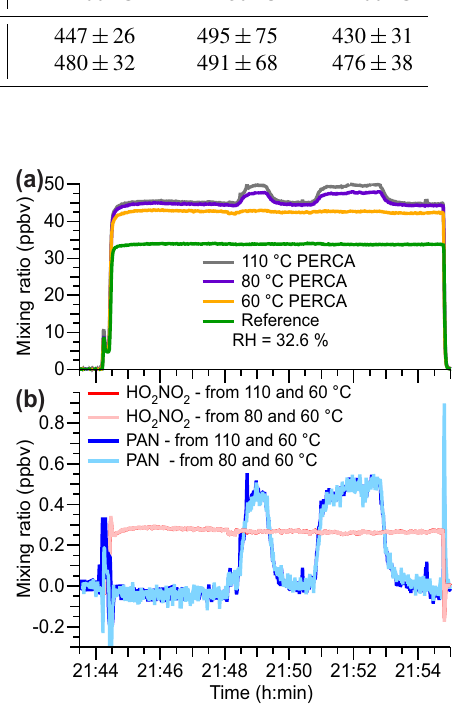
Figure 12. Demonstration of differential temperature TD-PERCA- CRDS. (a) Time series of NO 2 mixing ratios observed by an un- heated reference channel and three TD-PERCA channels oper- ated at 60, 80, and 110 ◦ C, respectively. PNA was sampled from 21:44:30 to 21:54:45, and PAN was added at ∼ 21:49 and ∼ 21:52. (b) Mixing ratios of PAN and PNA calculated from (a) .